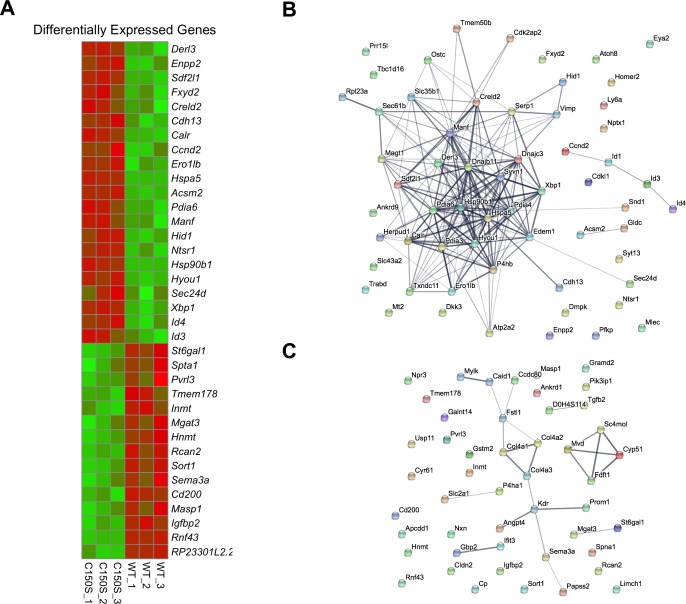
Transcriptome analysis in mTAL cells expressing wild type or C150S mutant uromodulin.(A) Heat map showing differentially expressed genes in mTAL cells expressing C150S uromodulin compared to wild type ones. Cut off: fold change > 1.5; P adjusted < 0.05. (B) STRING analysis showing networks formed by proteins encoded by up-regulated genes in mTAL cells expressing C150S uromodulin. Edges represent protein-protein association (physical or functional); their thickness is proportional to confidence. (C) Same analysis as in panel B for down-regulated genes. The proteins encoded by these genes are not forming relevant networks.